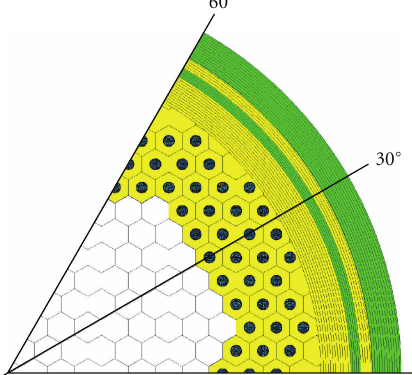
Figure 5: Axial view of the sixth reactor with three rows of FE closest to the RPV (sector 0 ◦ to 60 ◦ ).